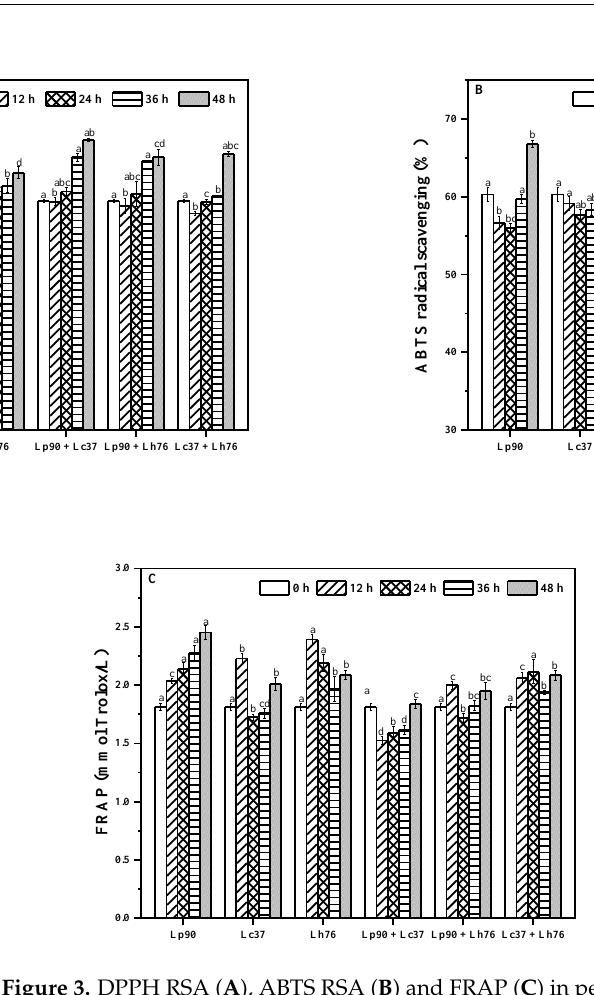
Figure 3. DPPH RSA ( A ), ABTS RSA ( B ) and FRAP ( C ) in pear juice fermented by monoculture and binary mixture of lactic acid bacteria. Values in the same pattern column with different letters are significantly different ( p < 0.05). Abbreviations: DPPH RSA, 1,1-Diphenyl-2-picrylhydrazyl radical scavenging ability; ABTS RSA, 2, 2’-azino-bis (3-ethylbenzothiazoline-6-sulfonic acid) radical scav- enging ability; FRAP, ferric reducing antioxidant power; Lp90, Lactiplantibacillus plantarum 90; Lc37, Lacticaseibacillus casei 37; Lh76, Lactobacillus helveticus 76; Lp90 + Lc37, mixture of Lactiplantibacillus plantarum 90 and Lacticaseibacillus casei 37; Lp90 + Lh76, mixture of Lactiplantibacillus plantarum 90 and Lactobacillus helveticus 76; Lc37 + Lh76, mixture of Lacticaseibacillus casei 37 and Lactobacillus helveticus 76.